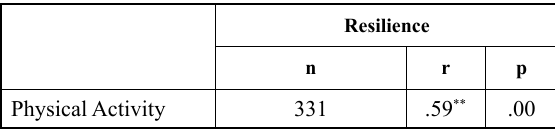
Table 1. The correlation results of physical activity and psychologi-